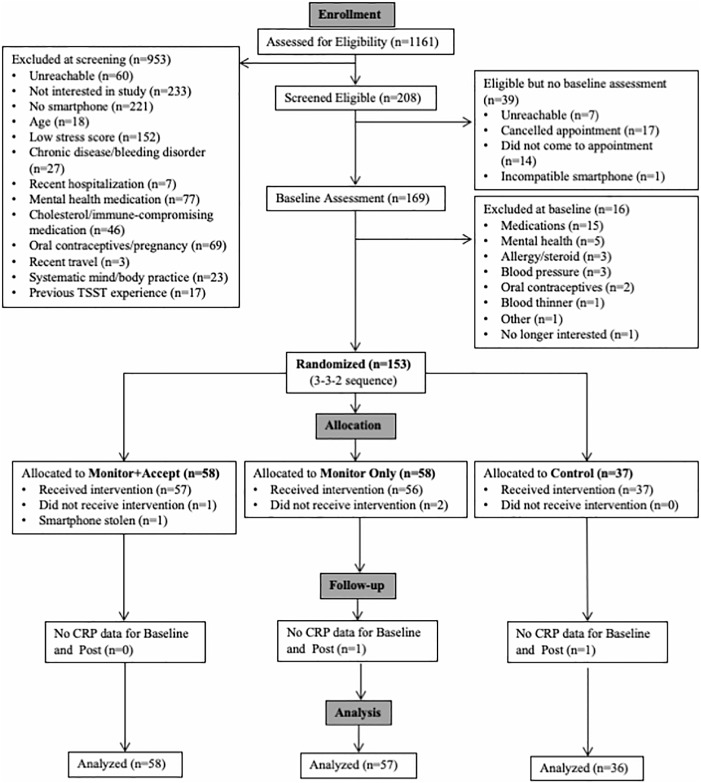
CONSORT flow charts.